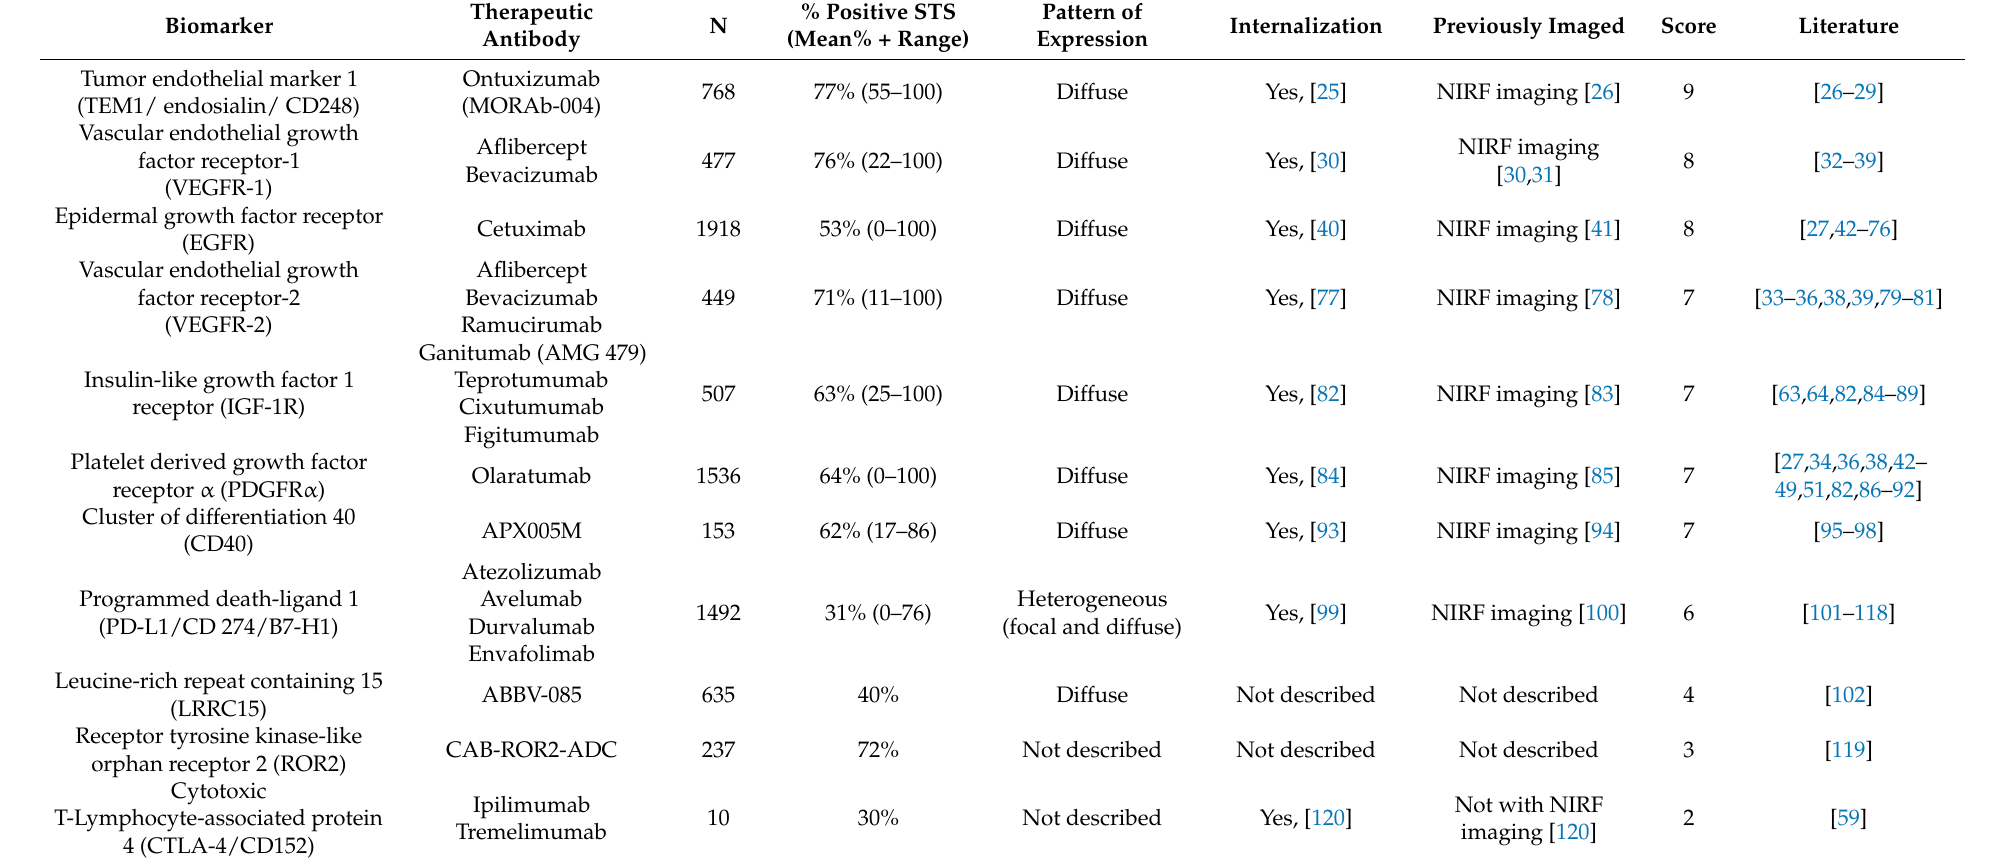
Table 2. Summarized data regarding eleven reviewed biomarkers (in descending order of the modified target selection criteria